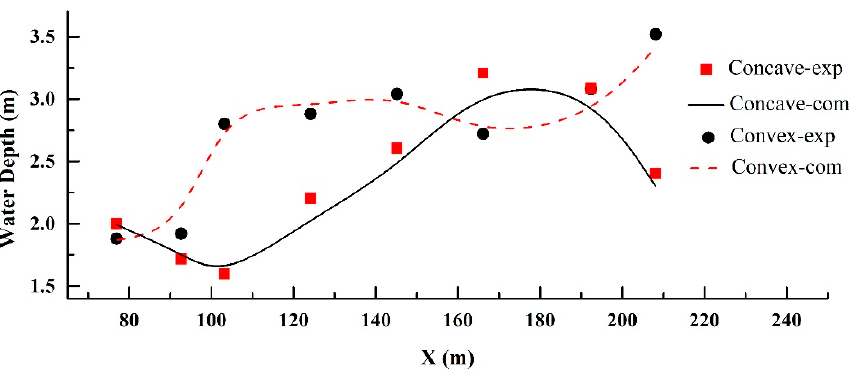
Figure 12. The water depth in the experimental measurement (exp) and numerical simulation (com).